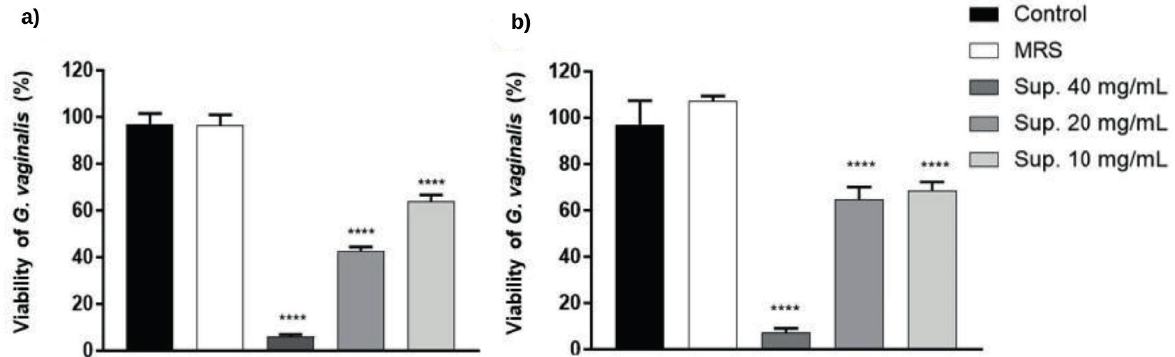
Figure 2. Antagonistic effect of the culture supernatant of Lactiplantibacillus plantarum 6.2 in different concentrations against Gardnerella vaginalis after 24 h (a) and 48 h (b) of incubation. Each value corresponds to the mean ± standard deviation of triplicates. Signifi cant differences from the control are indicated by asterisks (**** p